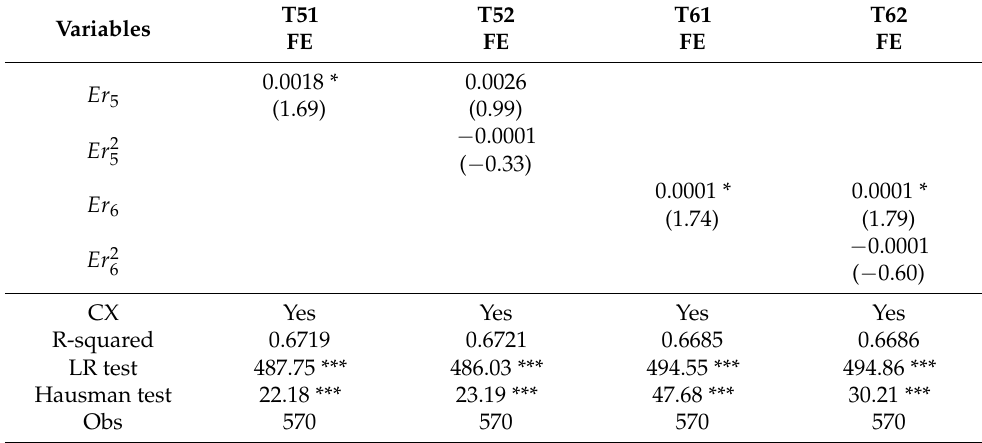
Table 6. Linear and quadratic regressions of autonomous environmental regulations: Nationwide.